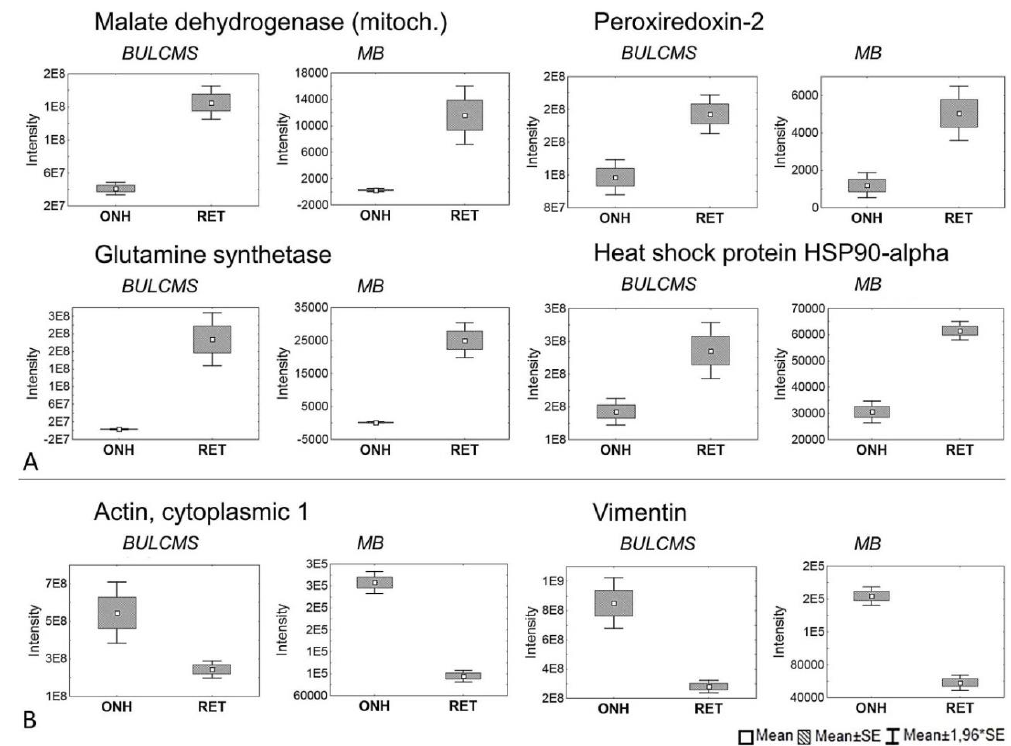
Figure 7. ONH / RET tissue-specific proteins determined by BULCMS and MB. ( A ) Exemplary metabolic enzymes and stress-related proteins show higher levels in RET than in ONH tissue ( p < 0.05).